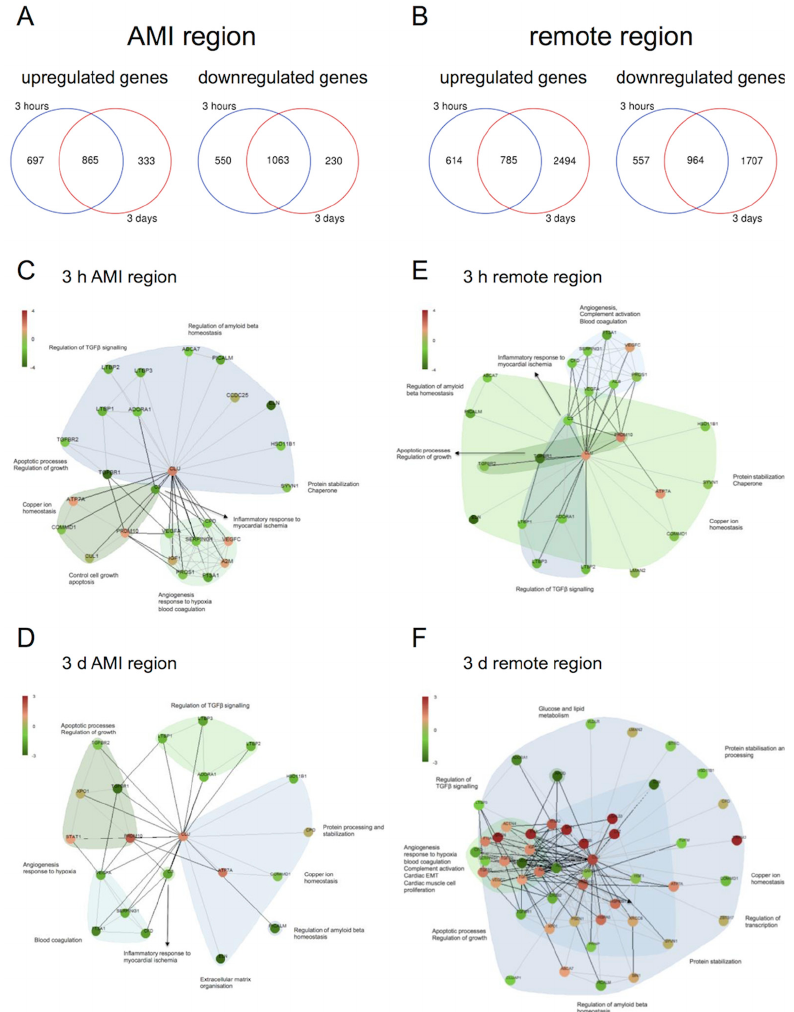
Figure 6. Venn diagrams with the number of significantly up- and downregulated protein coding genes in the groups 3 hours and 3 days after myocardial infarction onset, related to controls in the AMI ( A ) and remote region ( B ). Protein-protein interactions of the differentially expressed genes focused on CLU in AMI tissue at 3 hours ( C ) and 3 days ( D ) and remote tissue 3 hours ( E ) and 3 days ( F ) after AMI onset with their main functional classes. CLU was upregulated both 3 hours and 3 days after myocardial infarction onset in AMI tissue and remote region. Red, upregulated; green, downregulated genes, n = 15.